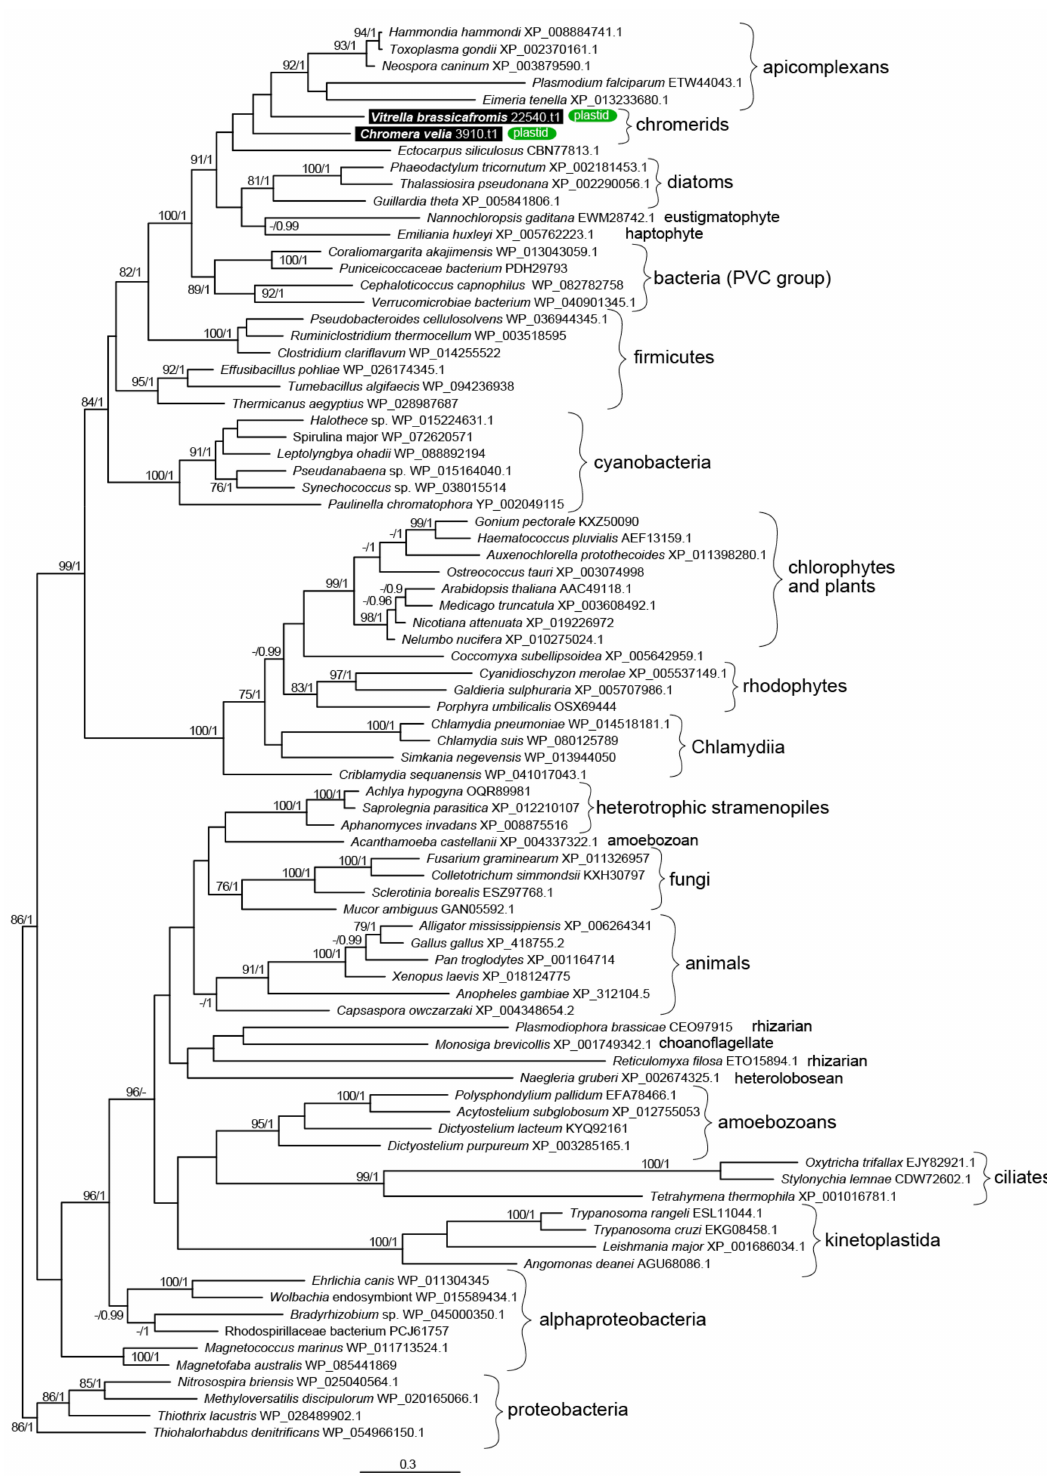
Figure 3. The detailed maximum likelihood phylogeny of ketoacyl synthase domains of type II fatty acid synthases. Bootstrap for 1000 repetitions and Bayesian pp values (BS1000 / 1M, CAT / LG models) are displayed above the branches. Predicted subcellular locations are